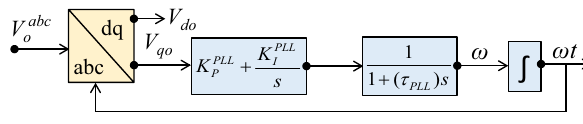
Fig. 3 Model of the phase-locked